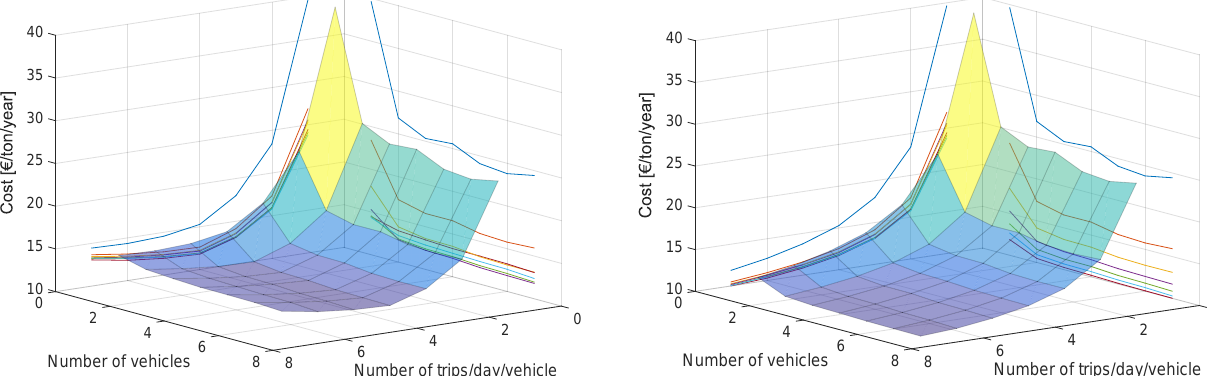
Figure 20. Annual transportation cost per ton as a function of number of daily trips per vehicle and number of vehicles. A penalty cost of 50% on operational cost was considered for number of trips more than four, ( left ); No-penalty, ( right ). Projection of surface lines can be seen in left and right